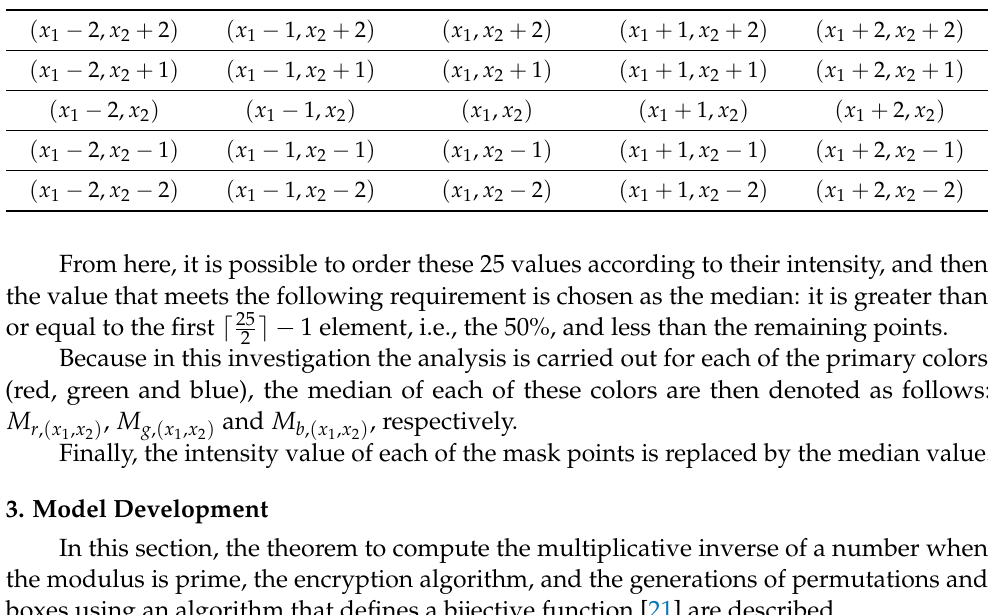
Table 1. A mask of 5 × 5 for the median